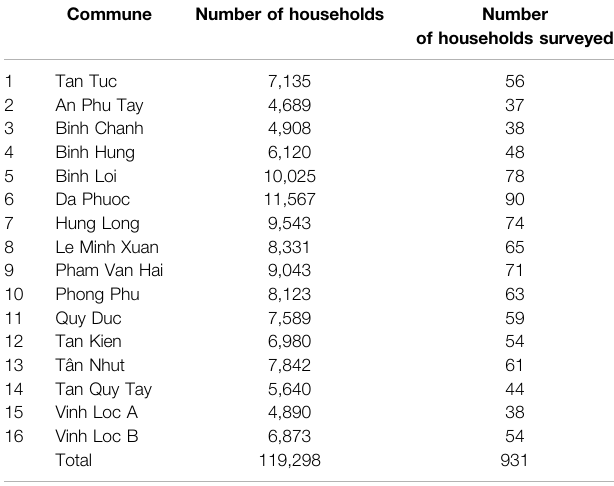
TABLE 1 | Distribution of surveyed households by the communes in the Binh Chanh district. Commune Number of